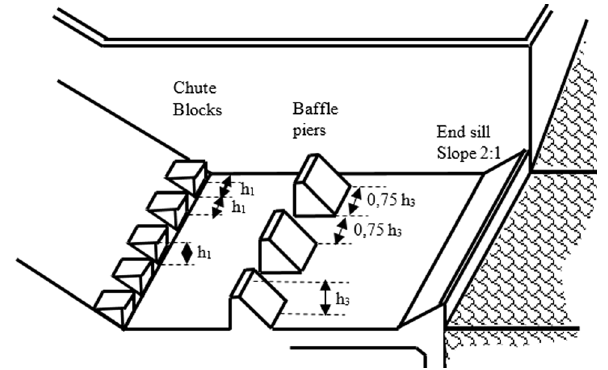
Fig. 4 Type III stilling basin (Peterka 1984)